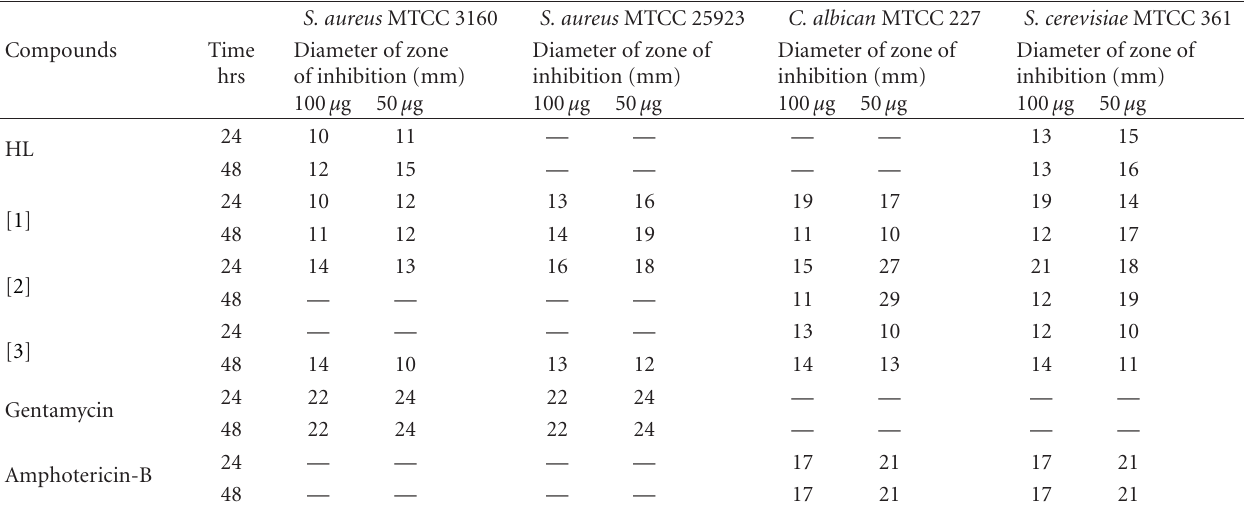
Table 1: Antimicrobial activity of ligand and their metal complexes.